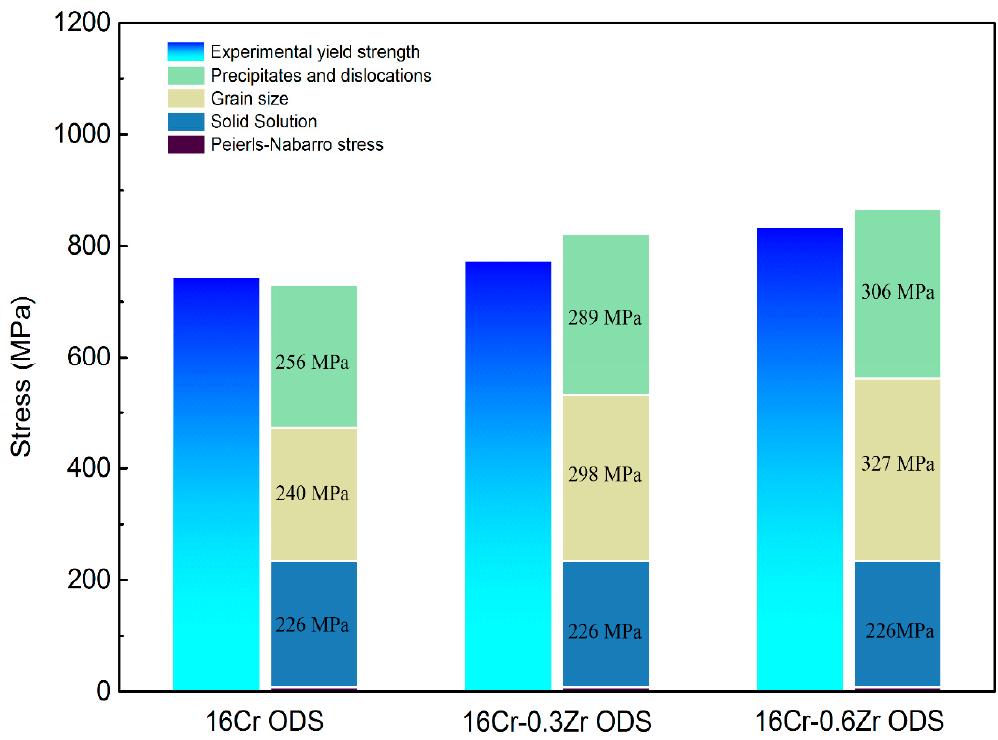
Figure 10. Comparison between the experimental and the estimated yield strength represented by components from Peierls-Nabarro stress, solid solution strengthening, grain boundaries strengthening, dislocation forest hardening and dispersion strengthening.